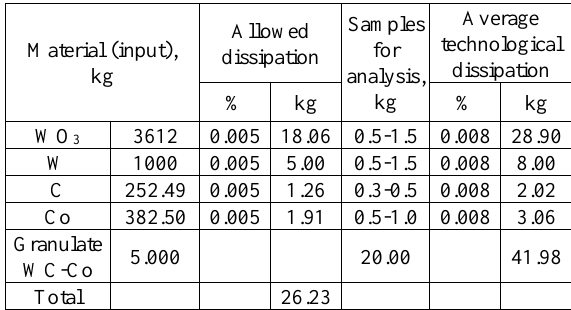
Table 2. Allowed material dissipation